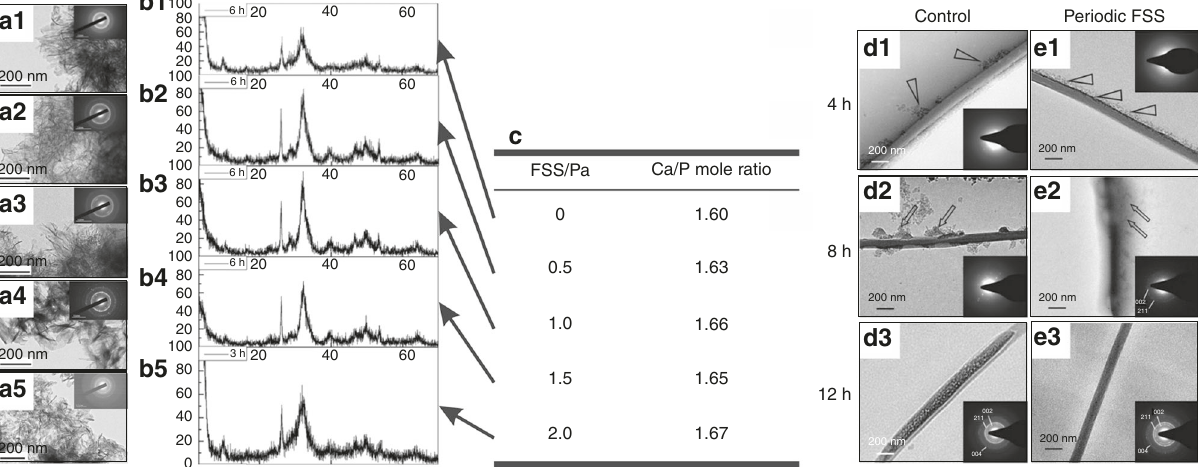
Fig. 9 Effect of FSS on conversion of ACP to HA. a – c In vitro system without cells, morphologies and crystal characteristics of ACP converting into HA after aging for 6 h 12 . Transmission electron microscopy (TEM) and X-ray diffraction characterization of HA under 0, 0.5, 1.0, 1.5 and 2.0 Pa FSS environments, respectively, with select area electron diffraction patterns in the top right corner of each TEM image. d , e In an in vitro system without cells, periodic FSS can inhibit the emergence of large clusters and promote the intra fi ber mineralization of apatite 13 . Figures adapted with permission from refs.